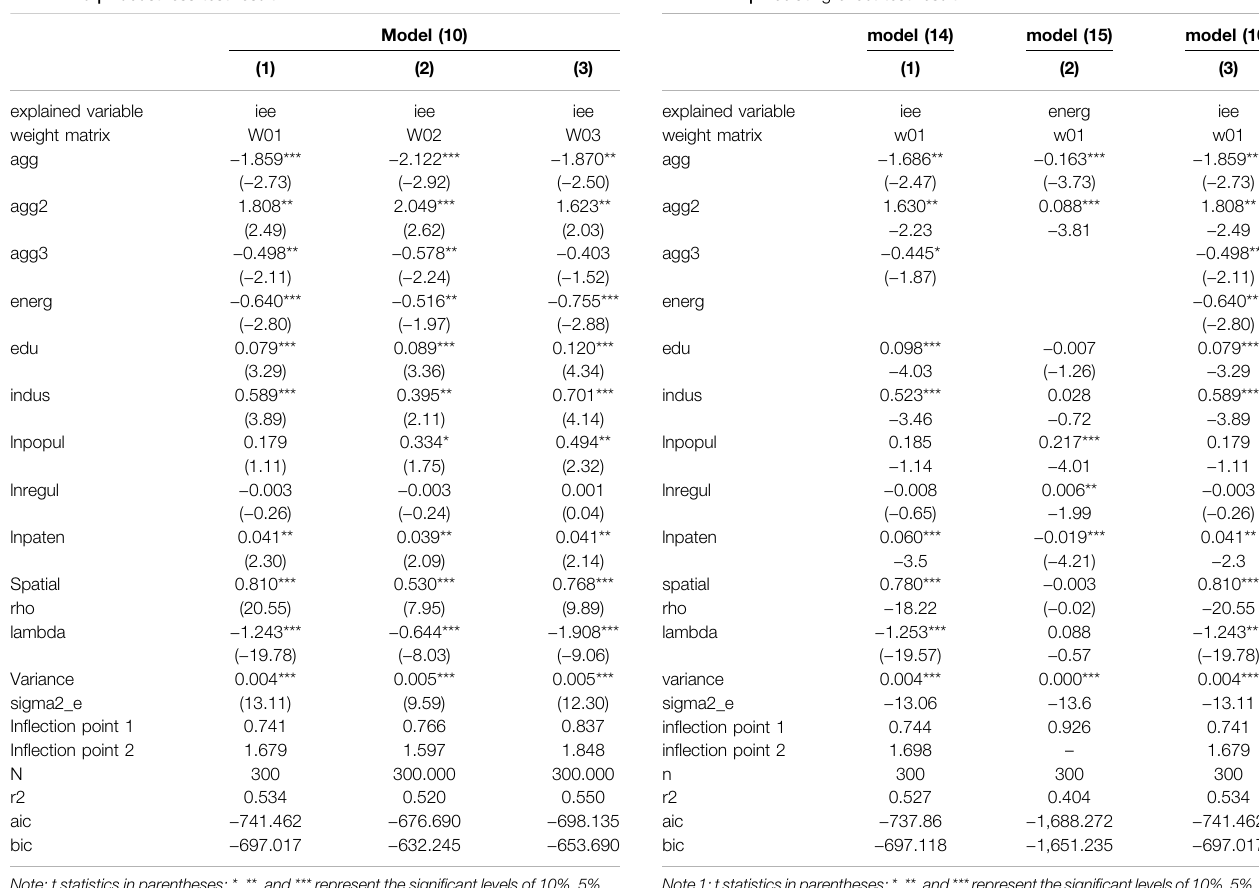
TABLE 10 | Robustness test result. TABLE 11 | Mediating effect test